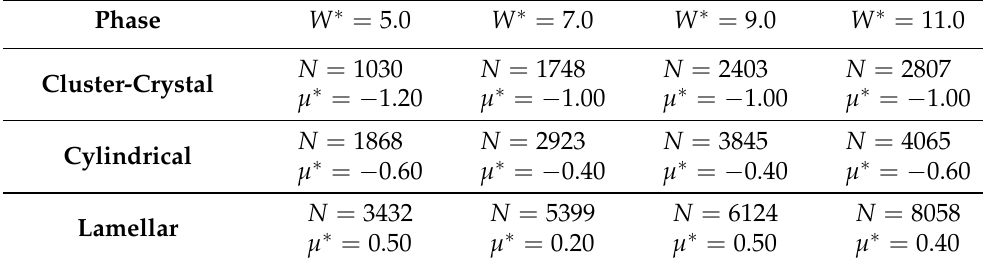
Table 1. Average number of particles confined in the slit pores at which the fluid organises into ordered structures at T ∗ = 0.3 at densities at which the bulk fluid assembles into a cluster-crystal, a cylindrical and a lamellar phase. Note that the chemical potential for the more dense lamellar phase might not be reliable due to the low acceptance probability of the insertion/deletion MC moves. In any case, we only used these simulations to generate the initial configurations for the NVT MD runs. W ∗ =